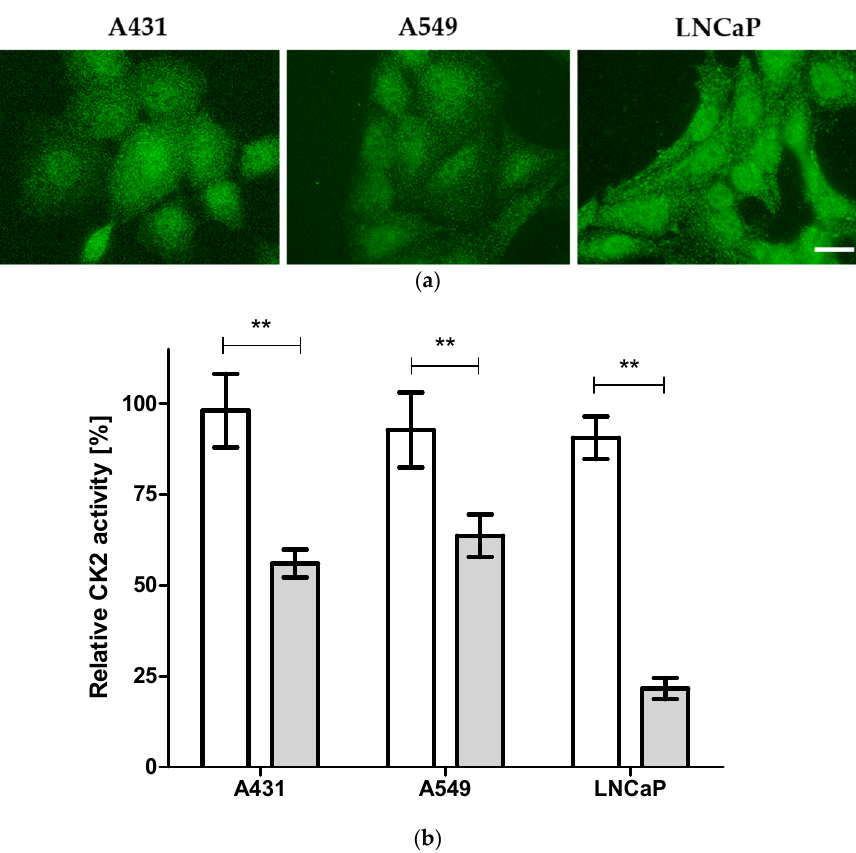
Figure 2. CK2 inhibition by 4p in three different cancer cell lines. ( a ) Immunostained A431, A549, and LNCaP cells with anti-CK2 α antibody (1AD9, Santa Cruz Biotechnology, Santa Cruz, CA, USA) and corresponding fluorescently labeled secondary antibody. Scale bar = 20 µ M. ( b ) CK2 activity in lysates from cultured A431, A549, or LNCaP cells that were treated for 24 h with vehicle (1% DMSO) or 4p at 1 µ M (white bars) and 20 µ M (grey bars) was determined in a capillary electrophoresis-based enzyme activity assay [35]. Data represent mean ± SD from three independent measurements, each performed in triplicates. ** p <